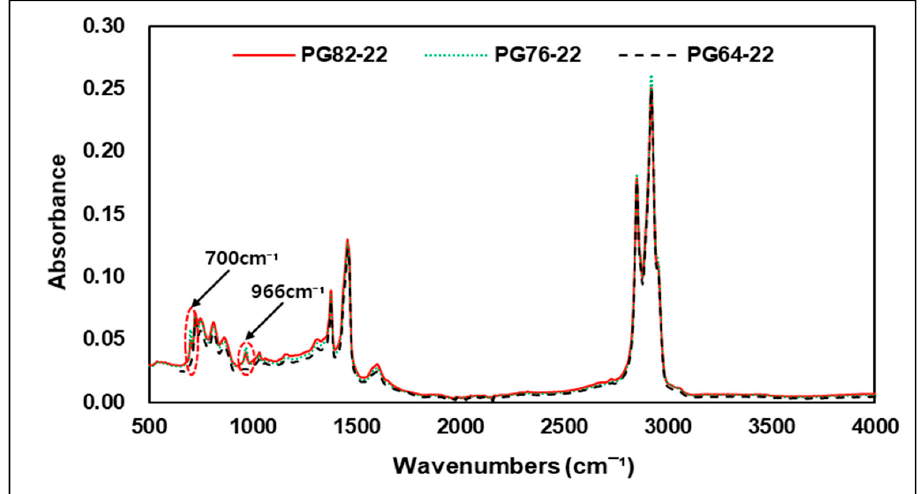
Figure 9. FTIR spectrum of PG 82-22, PG 76-22, and PG 64-22.